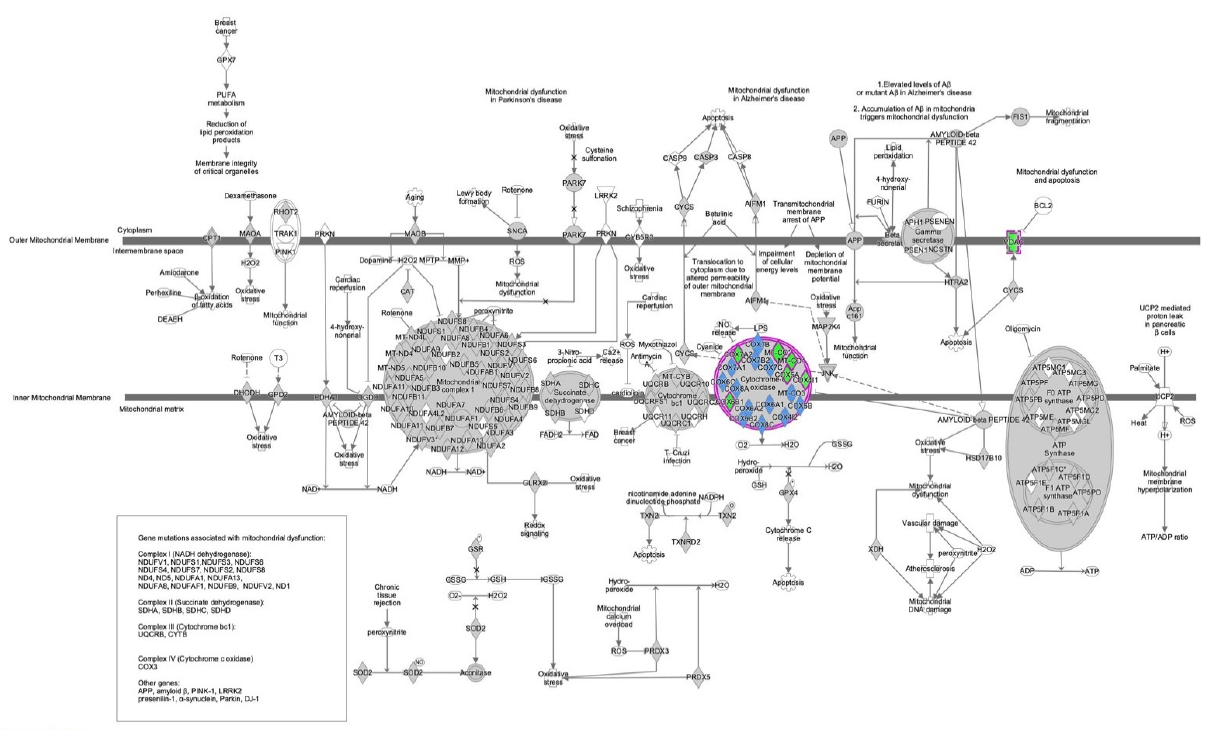
Figure 9. Visual diagram of the mitochondrial dysfunction canonical pathway identified by Inge- nuity Pathway Analysis (IPA) as being associated with both the sham-irradiated group and the 1 H- irradiated group. The diagram provides an image of how the pathway is structured, where the mol- ecules from the dataset are located, and a prediction of molecule activity. The nodes outlined in magenta are the molecules found in the dataset. The node color indicates expression value, and color intensity indicates degree of upregulation (red) or downregulation (green). Gray nodes are dataset molecules that were not significantly expressed and therefore did not pass the IPA analysis cutoff. Uncolored nodes were not part of our dataset but were incorporated into the pathway based on evidence stored in the Ingenuity Knowledge Base. Blue indicates a prediction of inhibited activ- ity. Solid lines indicate a direct interaction between molecules and the predicted relationship be- tween the molecules. Grey arrows indicate the effect is not predicted. The direction of the interaction is represented by arrows. For signaling pathways, an arrow pointing from one molecule to another indicates the cause of activation.